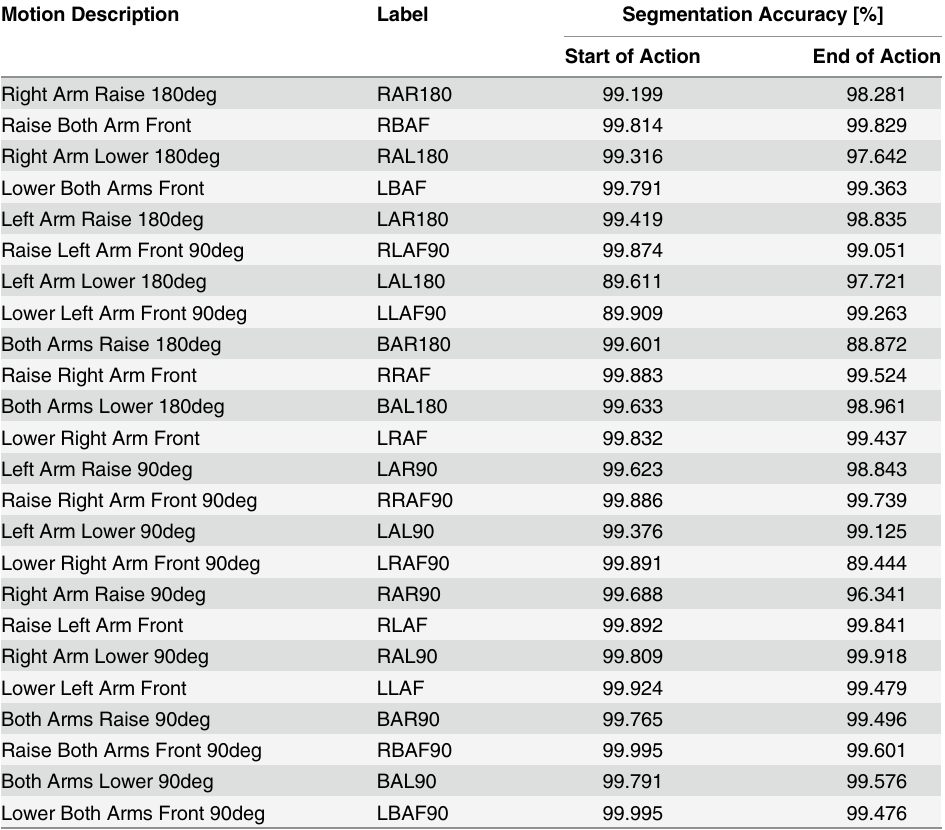
Table 1. Summary of Different Types of Actions Performed and their identification accuracy. Motion